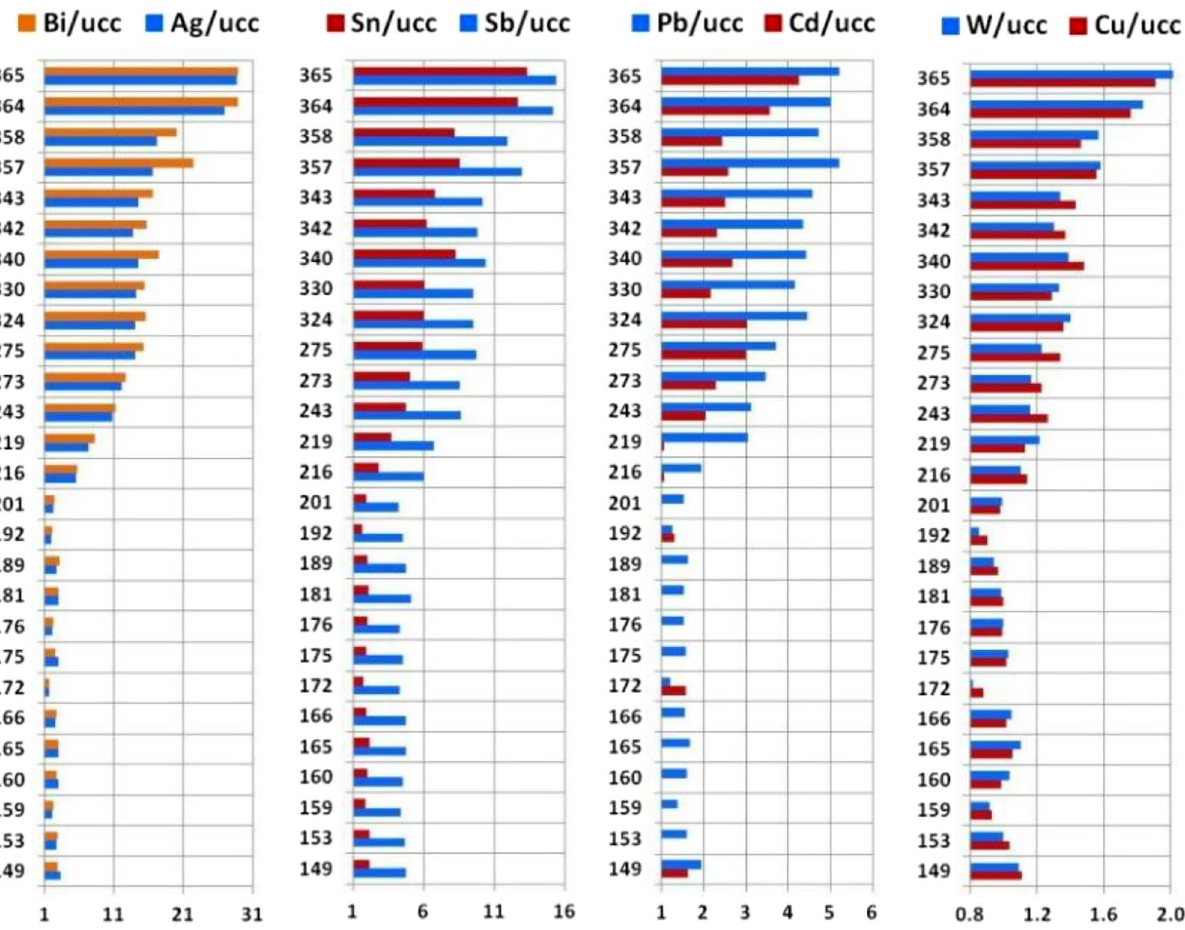
Figure 9. Distribution of chalcophiles and W concentrations in cryoconite of Nalli Glacier sampled at altitudes of 149–365 m a.s.l. The vertical axis shows the absolute altitude of the sampling spot, and the horizontal axis is the normalized contents of the elements. Normalization standard: UCC—Upper Continental Crust 48